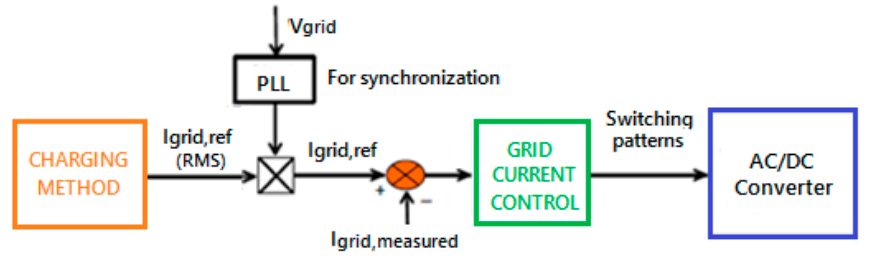
Figure 8. Main control blocks in the system.